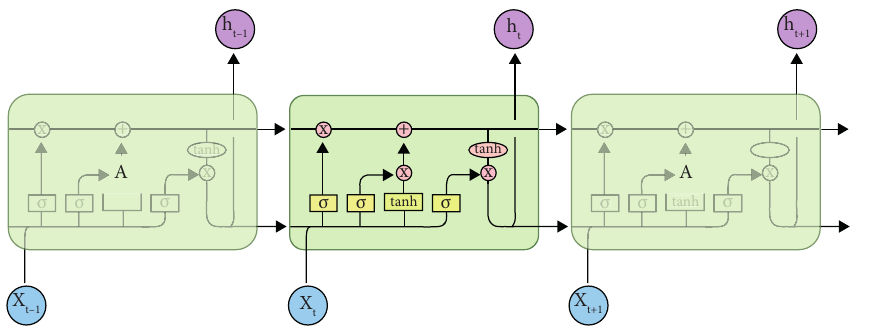
Figure 2: The network structure of